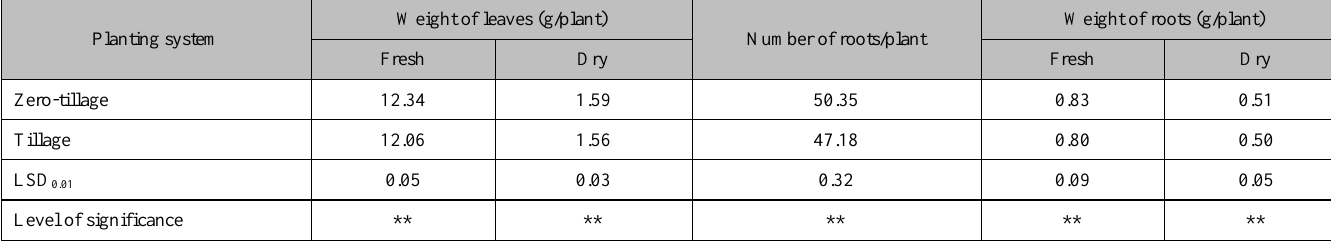
Table 3. Main effects of planting system on fresh weight, dry weight of leaves, number of roots, fresh weight and dry weight of roots. Planting system